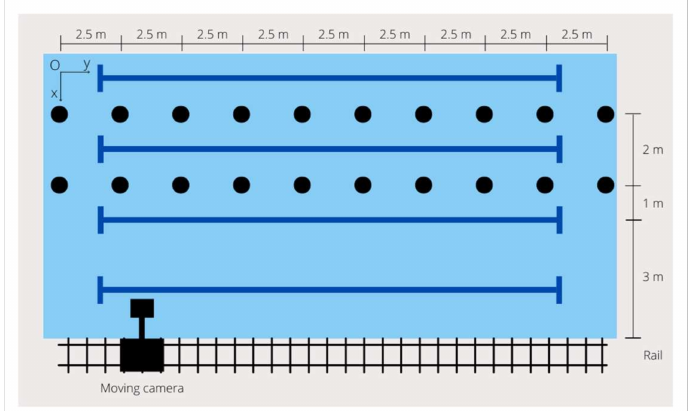
Figure 1. Protocol set up used to record swimmers’ performance (the markers were placed on the pool